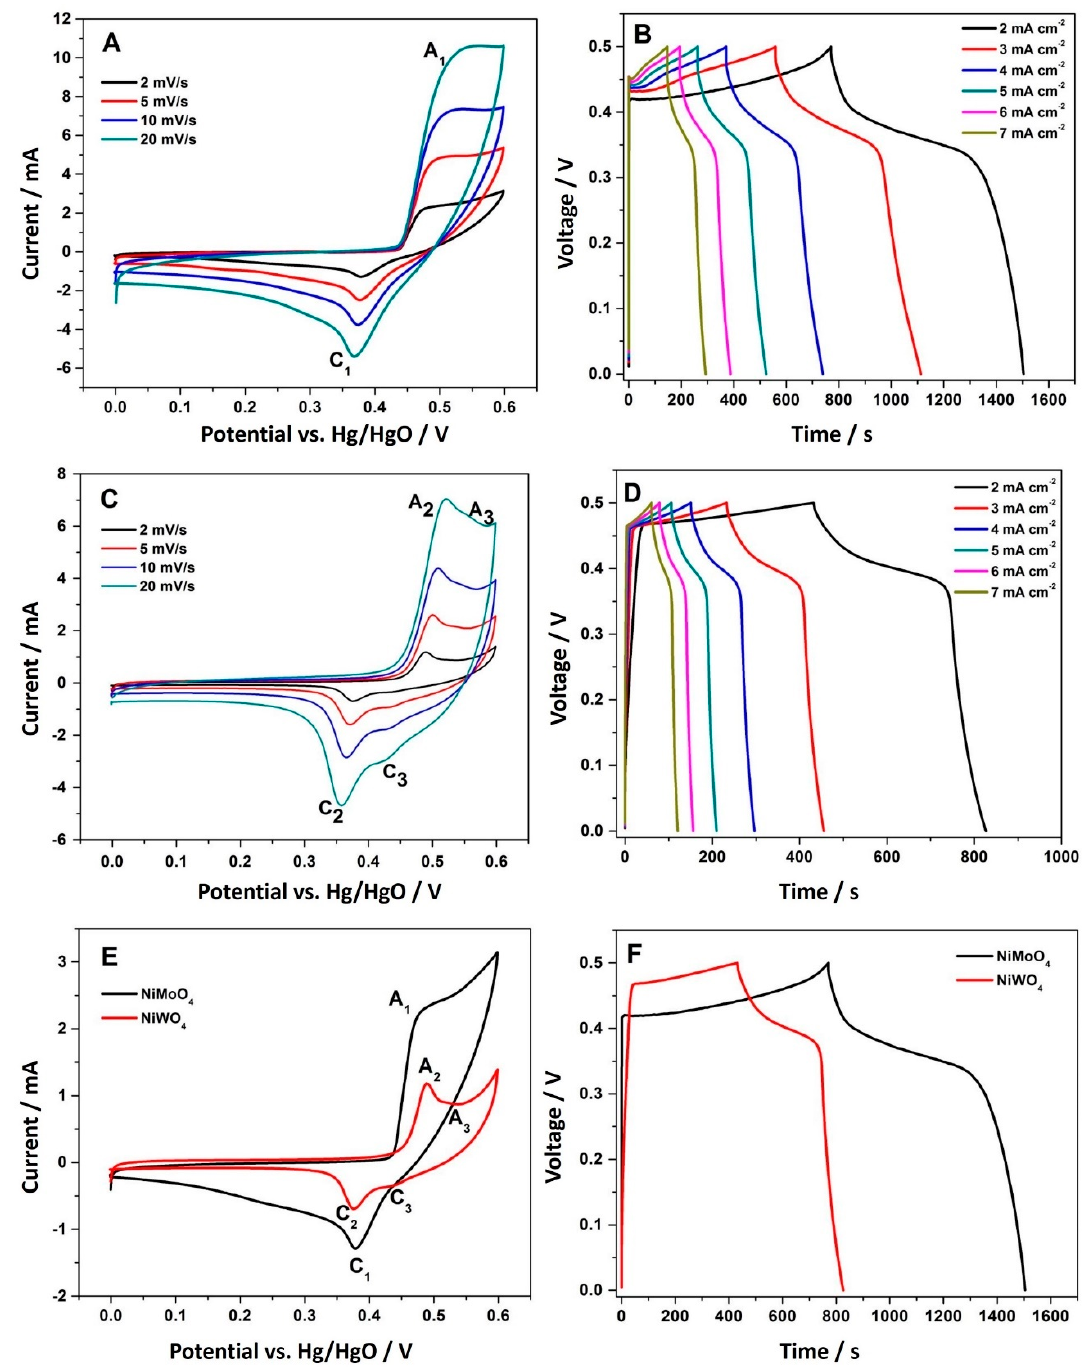
Figure 9. ( A , B ) Cyclic voltammetric (CV) curves and galvanostatic charge-discharge (CD) profiles of NiMoO 4 , ( C , D ) CV curves and CD profiles of NiWO 4 , ( E , F ) comparative CV at 2 mV/s and CD at 2 mA cm –2 of NiMoO 4 and NiWO 4 , respectively. The measurements are based on a three-electrode configuration with Hg/HgO as the reference electrode.